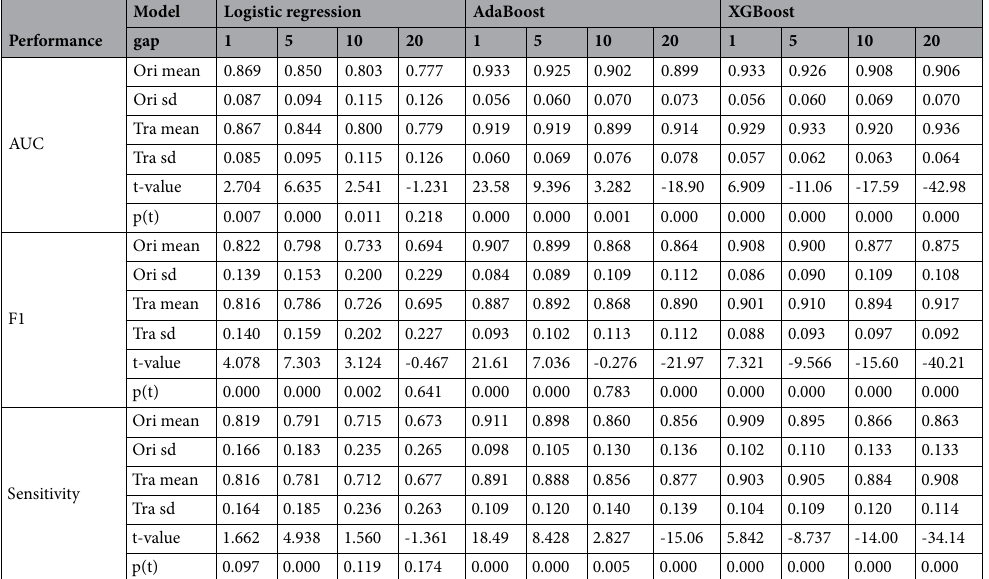
Table 1. Performance results for different forecasting gaps and methods with the original response variable and the transformed response variable. The gaps have values 1, 5, 10 and 20. Under each performance metric, four values are colored representing the best performance under the four gaps. The red one means that the transformed response variable has better performance, while the blue one indicates the original variable is